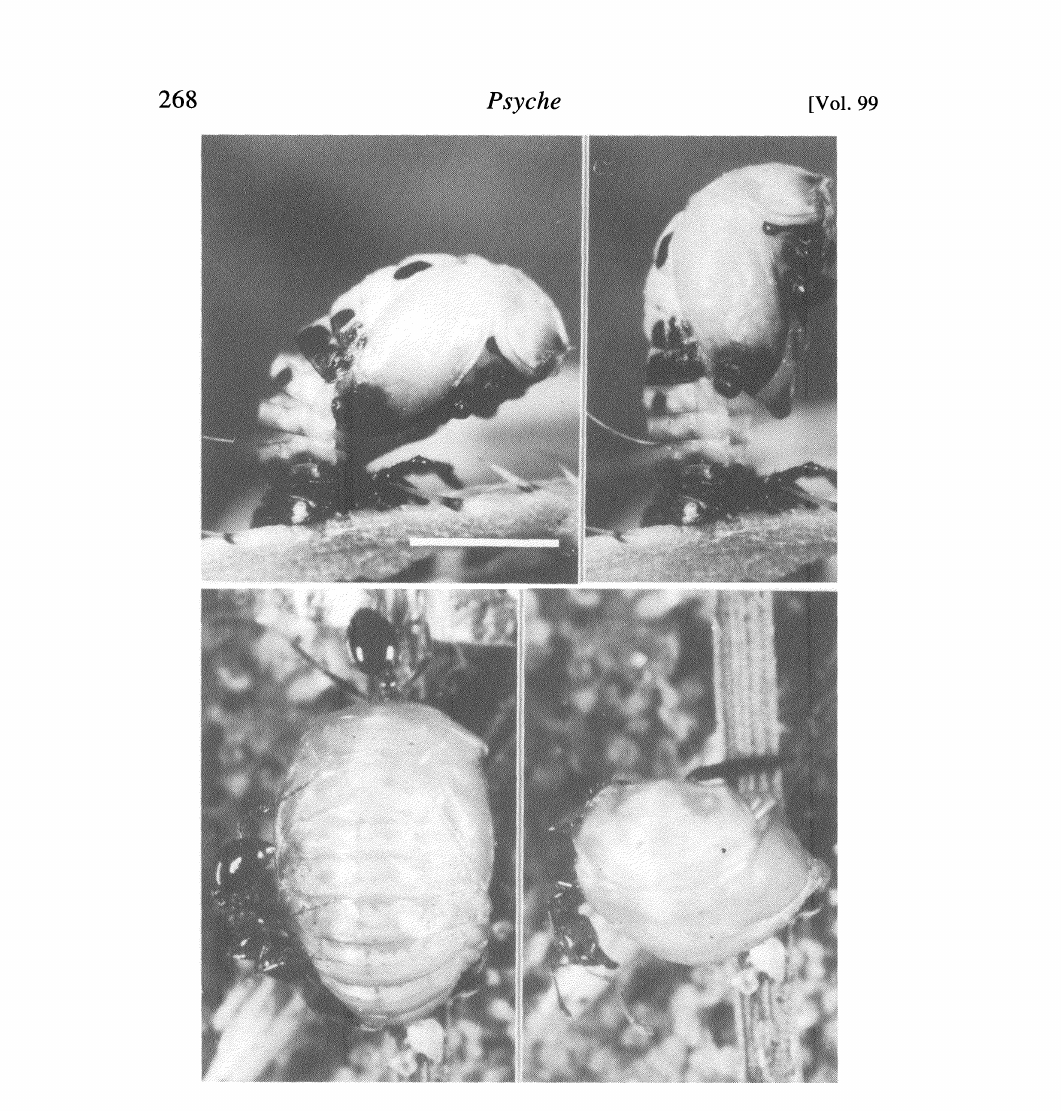
Figure 2. (Top) Stimulation of C. sanguinea pupa with bristle of a brush. On left, pupa is in resting position, and bristle is approaching posteriormost gin trap. On right, bristle has been inserted into the trap, and pupa has responded by executing the straightening reflex (the "flip"), causing the trap to clamp down on the bristle. (Bottom) Attack of fire ants (Solenopsis invicta) upon a C. sanguinea pupa. On left, an ant has mounted the pupa and is inspecting the region of the gin traps. On right, the pupa has responded by flipping, causing the ant to discontinue its probings. Note that mandibles of ant are still agape (in the tests, following such initial reac- tion, ants usually departed from pupae). Reference bar in upper left 2